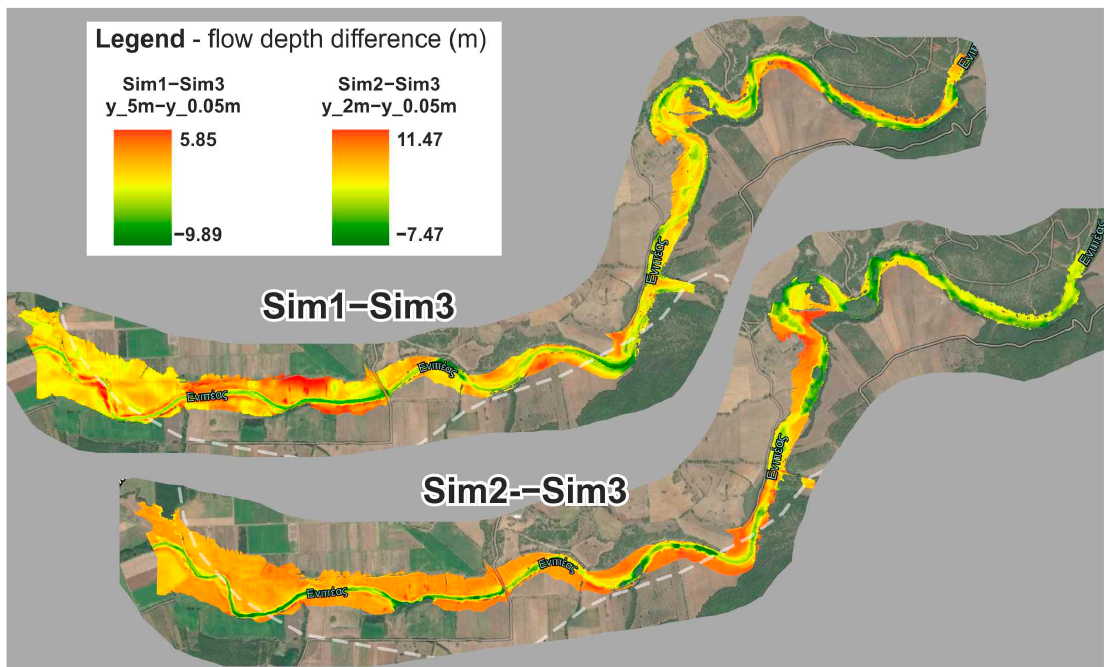
Figure 11. Flow depth differences between Sim 1 and Sim 3 (y_5 m − y_0.05 m) and Sim 2 and Sim 3 (y_2 m − y_0.05 m), presented only for the intersection of the respective inundated areas.